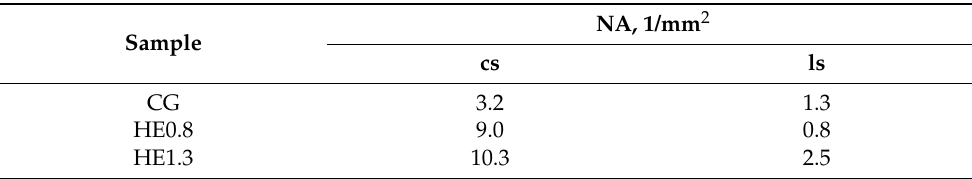
Table 6. Quantitative analysis of the number of pits per area on the cross-section (cs) and longitudinal section (ls) . Sample